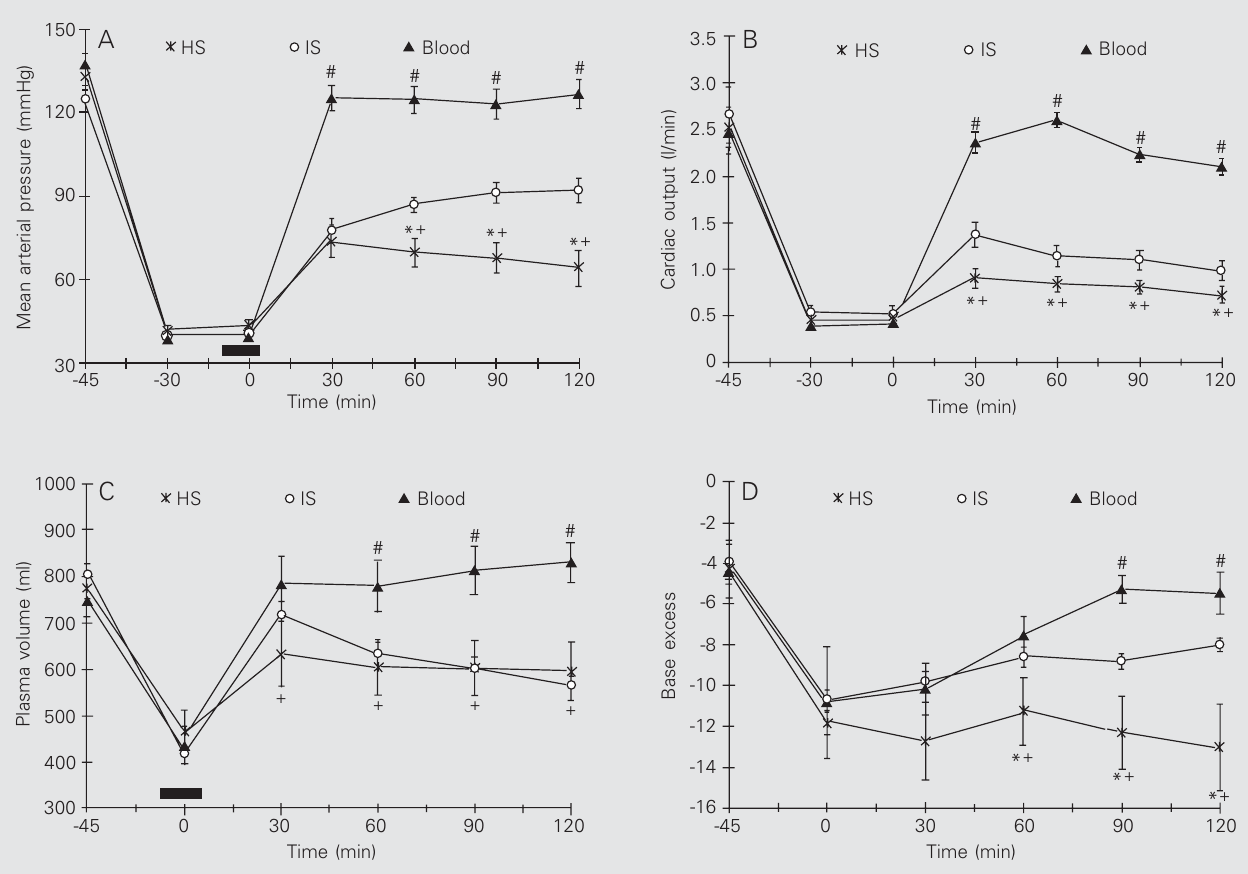
Figure 2. Effect of transitory reversible vagal blockade on the cardiovascular parameters during resuscitation of severely hemorrhagic shocked dogs with blood volume reinfusion (blood), isotonic saline reinfusion (IS), and hypertonic saline reinfusion (HS). The horizontal bar indicates when the reversible thermal vagal blockade was applied. Data are reported as means ± SEM for 9 dogs in each group. A , Mean arterial pressure, *P < 0.05, HS group vs IS group; + P < 0.05, HS group vs blood group; # P < 0.05, blood group vs IS group. B , Cardiac output, *P < 0.05, HS group vs IS group; + P < 0.05, HS group vs blood group; # P < 0.05, blood group vs IS group. C , Plasma volume, + P < 0.05, HS group vs blood group; # P < 0.05, blood group vs IS group. D , Base excess, *P < 0.05, HS group vs IS group; + P < 0.05, HS group vs blood group; # P < 0.05, blood group vs IS group. Statistical analysis: one-way ANOVA and Student-Newman-Keuls test.